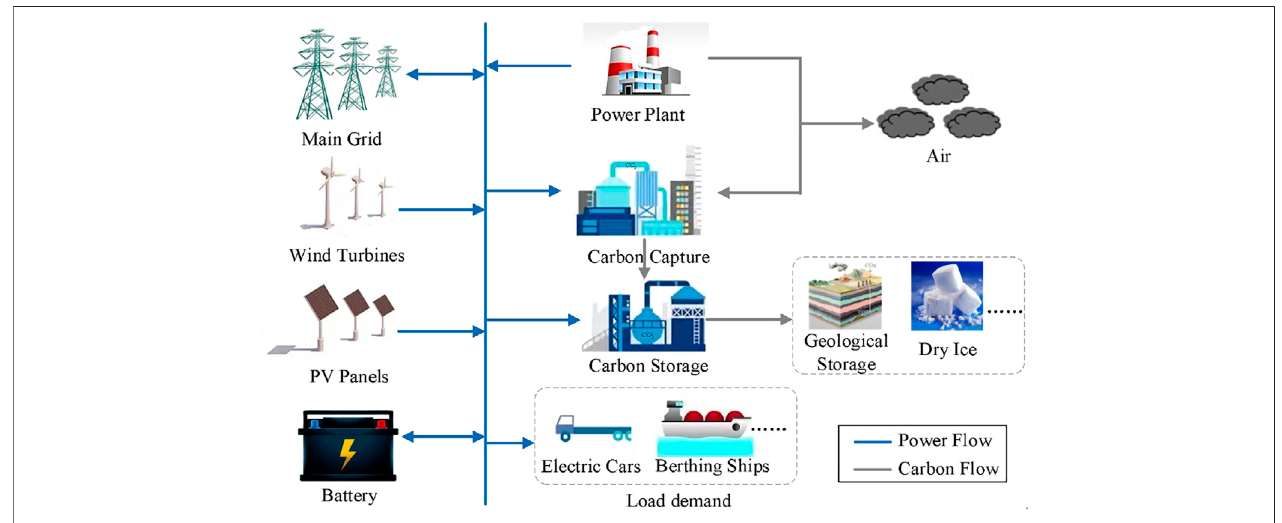
FIGURE 1 | Components of the low-carbon port